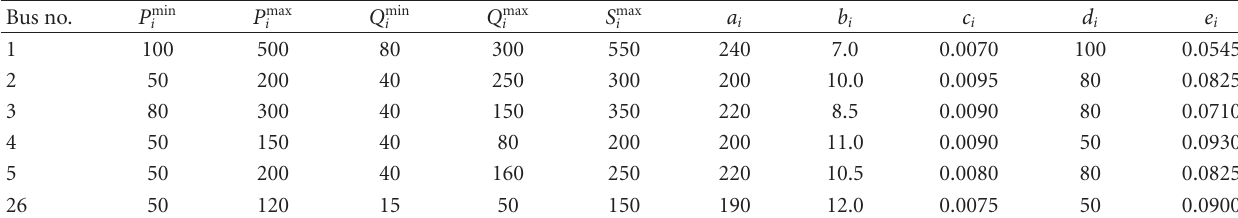
Figure 5: One-lone diagram of 26-bus system. Table 1: Generating unit capacity and coe ffi cients in 26-bus